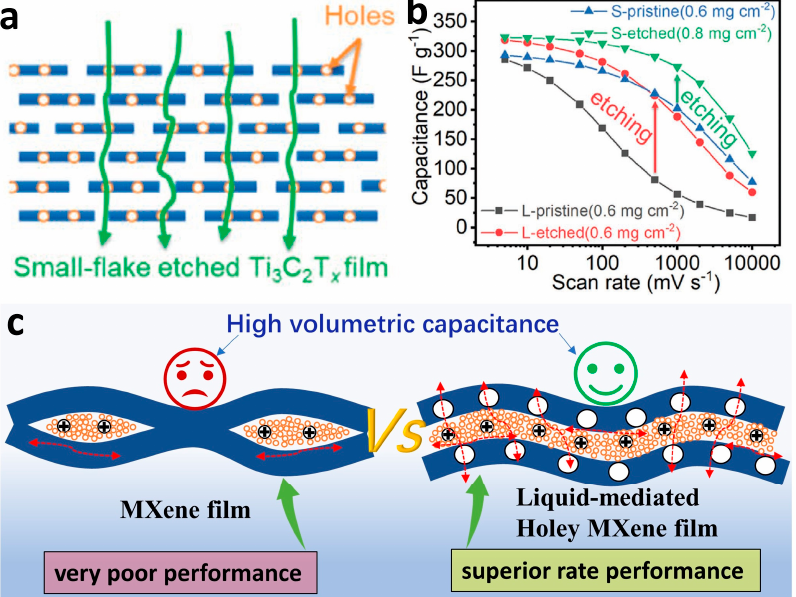
Figure 12. ( a ) Schematic illustration of ion diffusion pathways across the holey MXene film. ( b ) Capacitances of holey MXene film at different scan rates; reproduced from [52], with the permission of Wiley-VCH. ( c ) Schematic illustration of ion diffusion pathways across the liquid-mediated holey MXene film; reproduced from [53], with the permission of Elsevier.